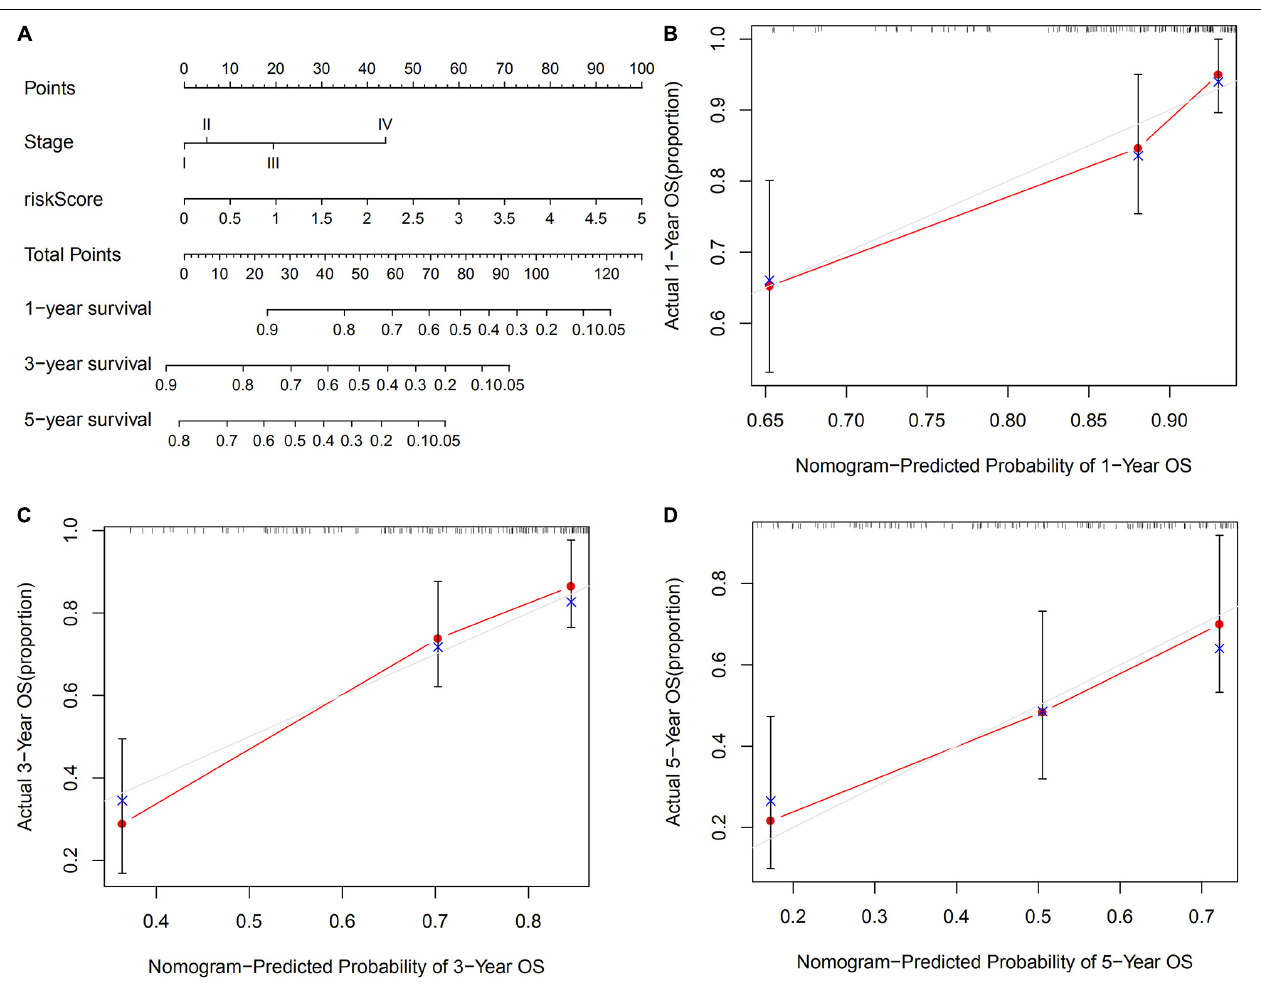
FIGURE 8 | Construction of a nomogram based on risk score and TNM stage in TCGA set. (A) A nomogram consists of risk score and stage to predict the OS of HCC patients at 1-, 3-, and 5-years. (B–D) Calibration curves to validate the prediction value of nomogram at 1-, 3-, and 5-year OS,